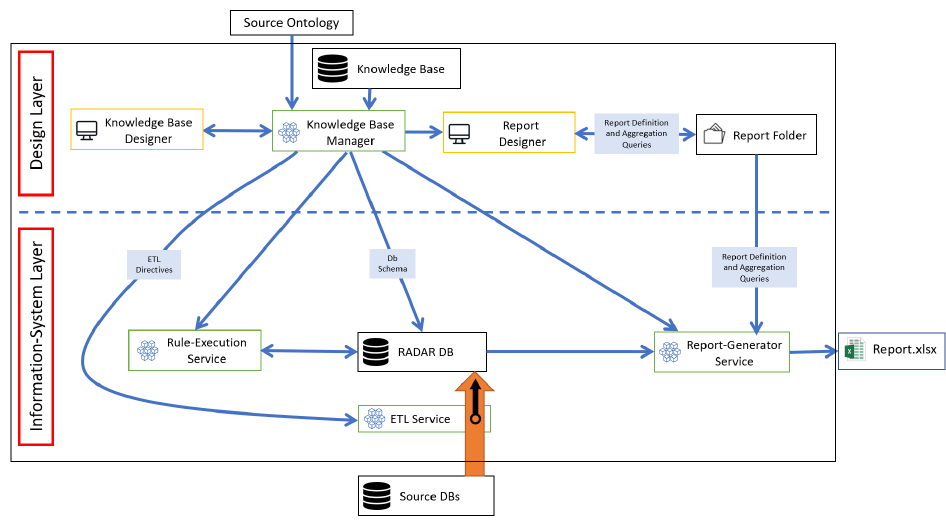
Figure 1. Architecture of the RADAR Framework